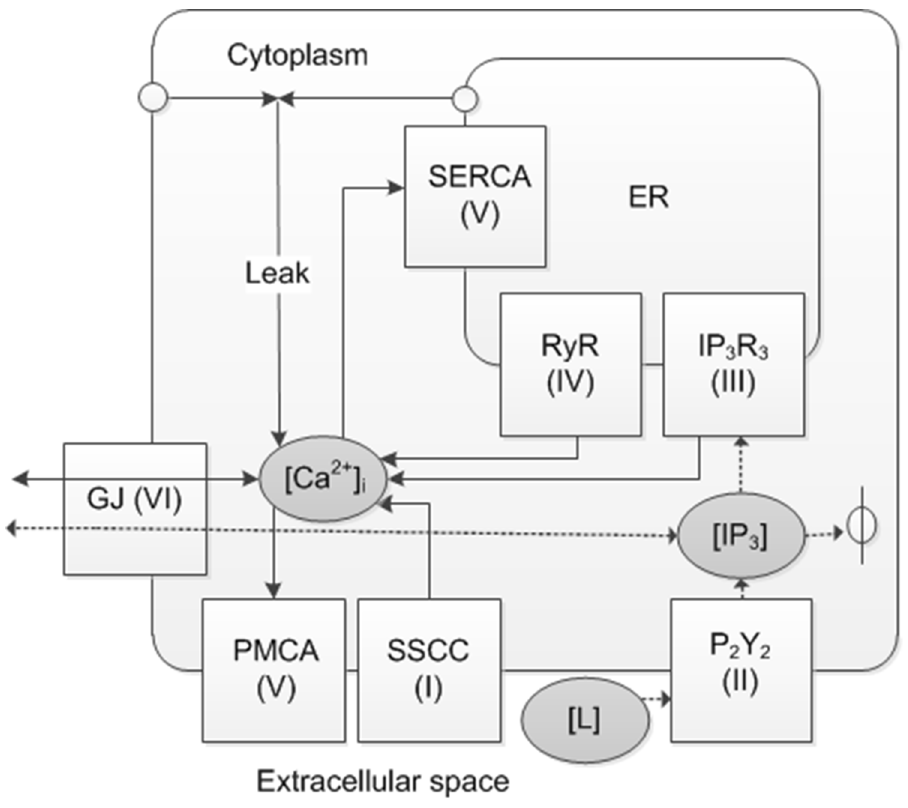
Fig 2. Schematic diagram of the Ca 2+ signaling model. Solid arrows represent Ca 2+ fluxes and dashed arrows IP 3 dynamics. Roman numerals denote the model components I-VI. Abbreviations: [Ca 2+ ] i = cytoplasmic Ca 2+ concentration, [L] = extracellular ligand concentration, [IP 3 ] = cytoplasmic IP 3 concentration, SSCC = stretch-sensitive Ca 2+ channel, P 2 Y 2 = purinergic receptor type P 2 Y 2 , IP 3 R 3 = IP 3 receptor type 3, RyR = ryanodine receptor, SERCA = sarco/endoplasmic reticulum Ca 2+ ATPase, PMCA = plasma membrane Ca 2+ ATPase, Leak = combinatory Ca 2+ leak from the extracellular space and the endoplasmic reticulum (ER), GJ = gap junction, ϕ = degradation.